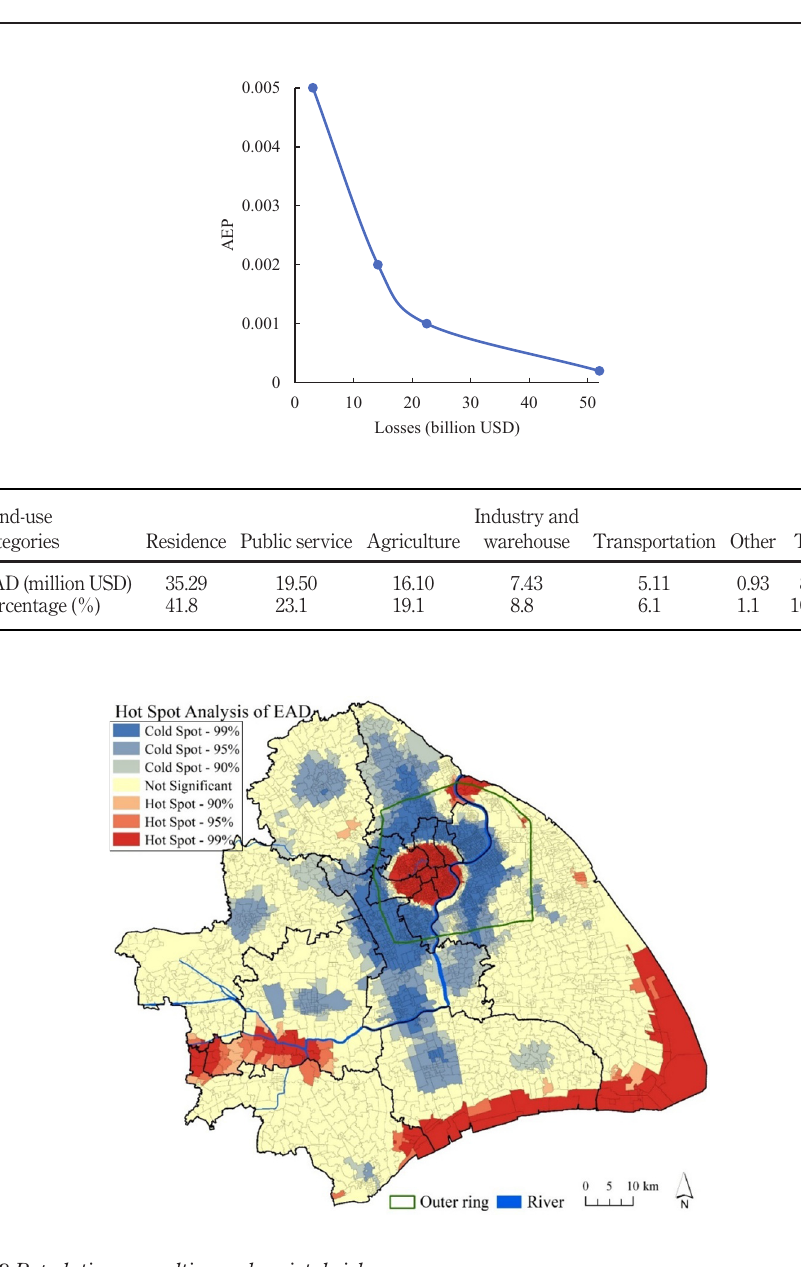
Figure 6. Hot and cold spots of EAD in Shanghai